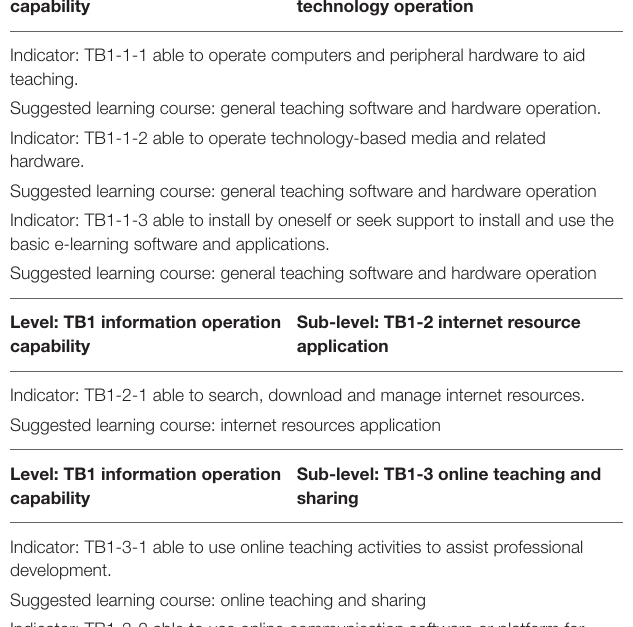
TABLE 5 | Teaching team – basic ability. Level: TB1 information operation capability